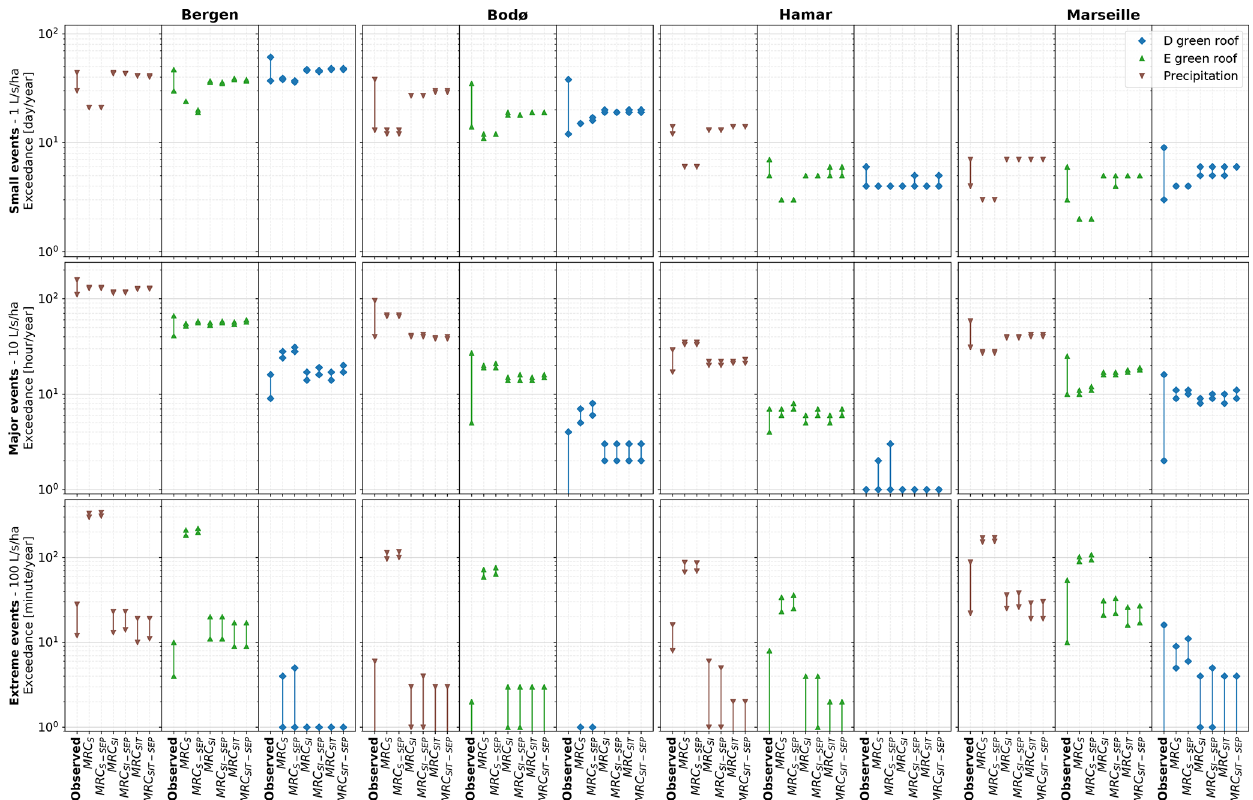
Figure 6. Performance of the downscaled time series in Bergen, Bodø, Hamar, and Marseille; exceedance frequency for small events, major events, and extreme events. The stochastic variability linked to the downscaled time series is evaluated with the 5th to 95th percentiles. Observed represents the fine-resolution observed time series or simulation using this time series as input. The 5th to 95th percentiles were estimated with a 3-year moving window. Due to log axis, occurrences lower than 10 0 are not